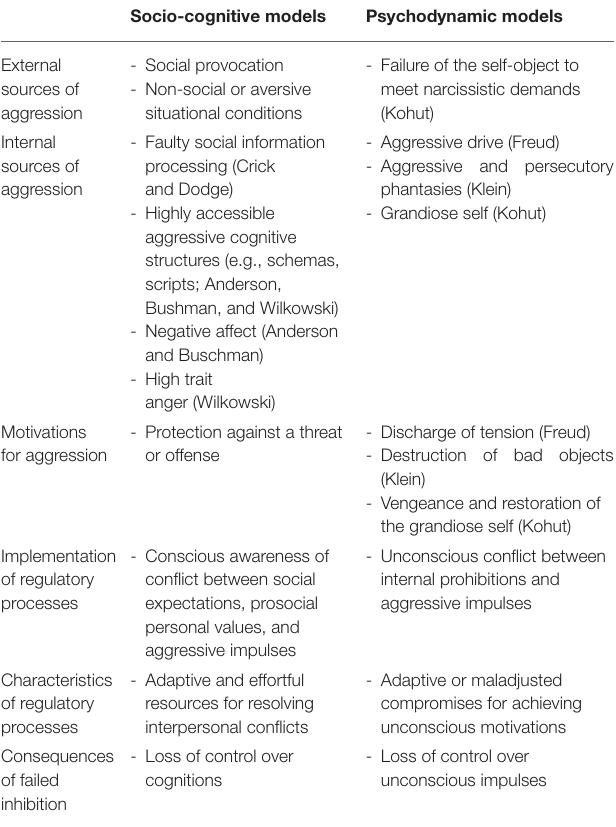
TABLE 1 | Comparisons between socio-cognitive and psychodynamics models on various dimensions of aggression. Socio-cognitive